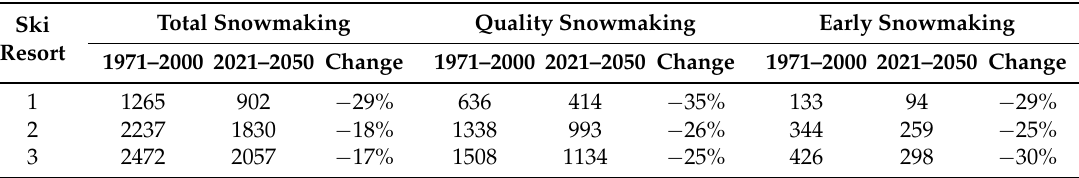
Table 3. Projected Changes for Annual Snowmaking Capacities (hours) at the Major Ski Resorts in Northeast Turkey according to the RCP4.5 Scenario.